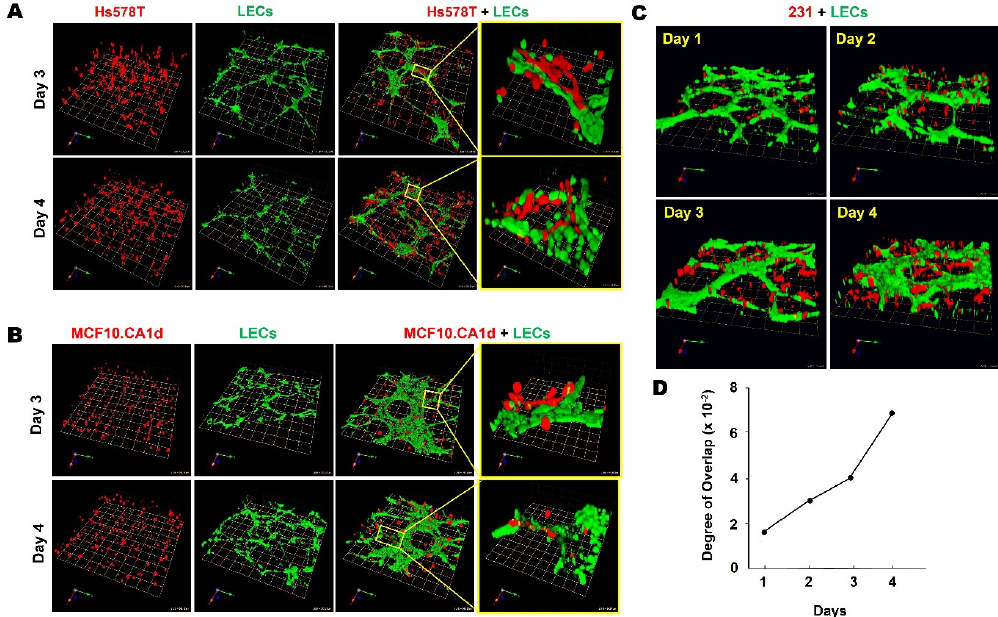
Figure 3. Spatiotemporal changes in interactions between TNBC spheroids and LEC networks could be observed over 4 days of direct 3D coculture. ( A , B ) Representative images of 3D reconstructions of monocultures of Hs578T ( A ), MCF10.CA1d ( B ) or LECs BFS ( A , B ) and Hs578T:LEC ( A ) or MCF10.CA1d:LEC ( B ) cocultures on days 3 and 4. Images are tiled from 16 contiguous fields; each grid represents 243 μ m. Enlarged images on the right illustrate interactions between TNBC spheroids and LEC networks in greater detail; each grid represents 43 μ m. ( C ) Representative time-course images of 3D reconstructions of 231:LEC MG direct cocultures. Images are tiled from 16 contiguous fields; each grid represents 243 µ m. ( D ) Quantitative analysis demonstrated a time-dependent increase in 231:LEC overlap over the 4 day period in direct 3D coculture. Degree of overlap = volume of 231s inside LEC networks/total volume of LEC